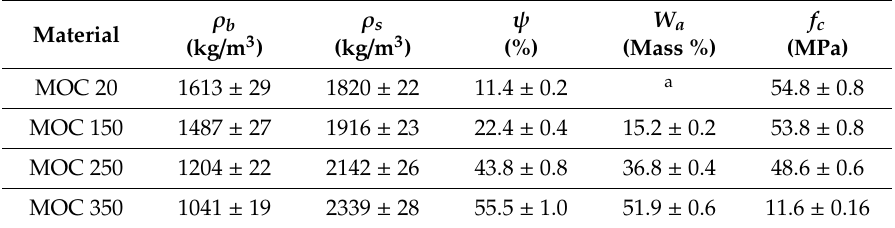
Table 2. Structural and mechanical parameters of MOC 5-1-8 phase